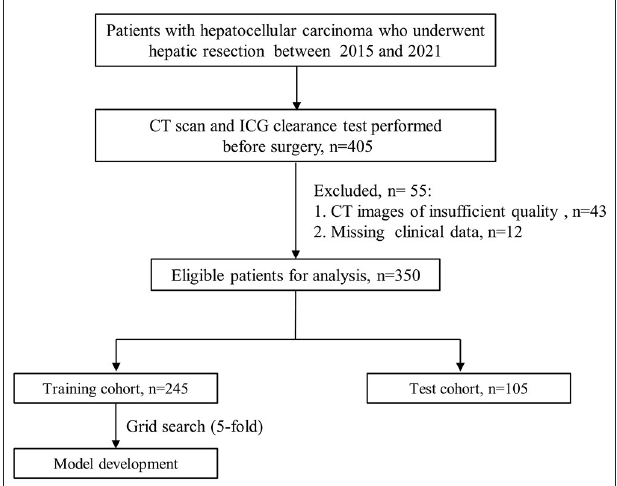
FIGURE 1 | Flow diagram of model development. ICG, indocyanine green; CT, computed